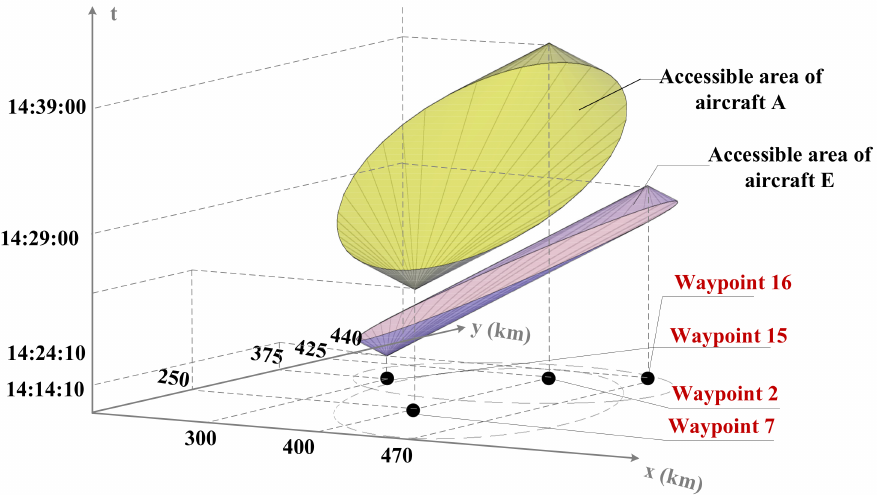
Figure 11. Conflict diagram of aircraft E and aircraft